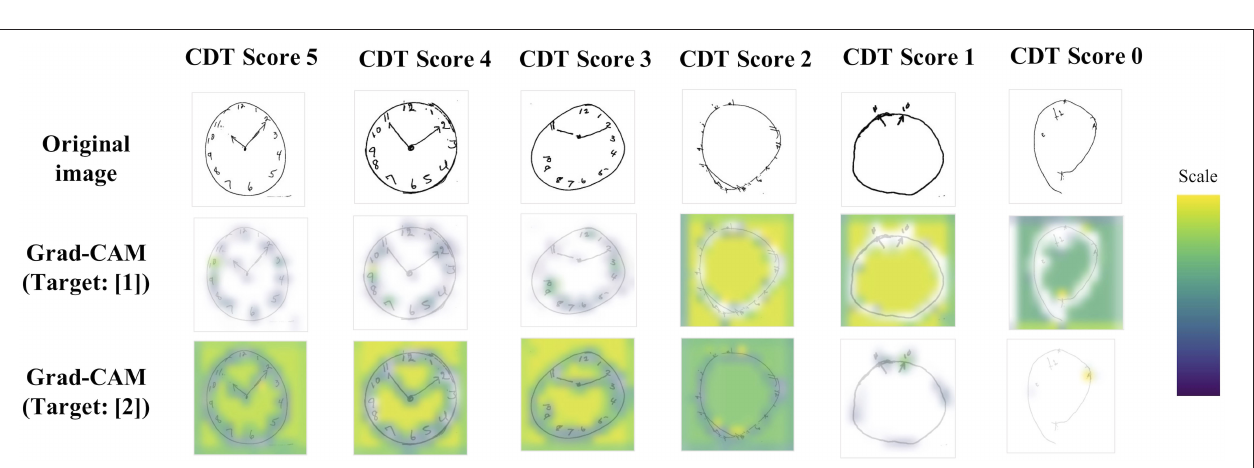
FIGURE 4 | Grad-CAM examples. Examples of imputed CDT images and their extracted features through the CNN network. Yellow or green color corresponds to the higher weighted region of interest. For target (1), clock letters and hands were referred to within clock images with a better quality. Meanwhile, for target (2), not only clock letters, hands, and outer circle, but also clock background spaces were also referred to within clock images with a better quality. CDT, Clock-Drawing Test; Grad-CAM, gradient-weighted class activation